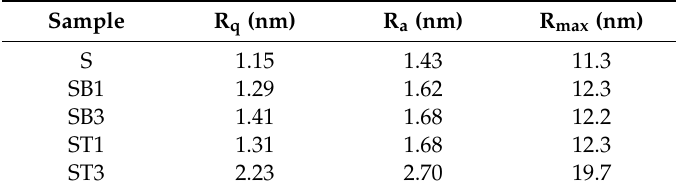
Table 1. Values of roughness parameters of pure Sylgard and its